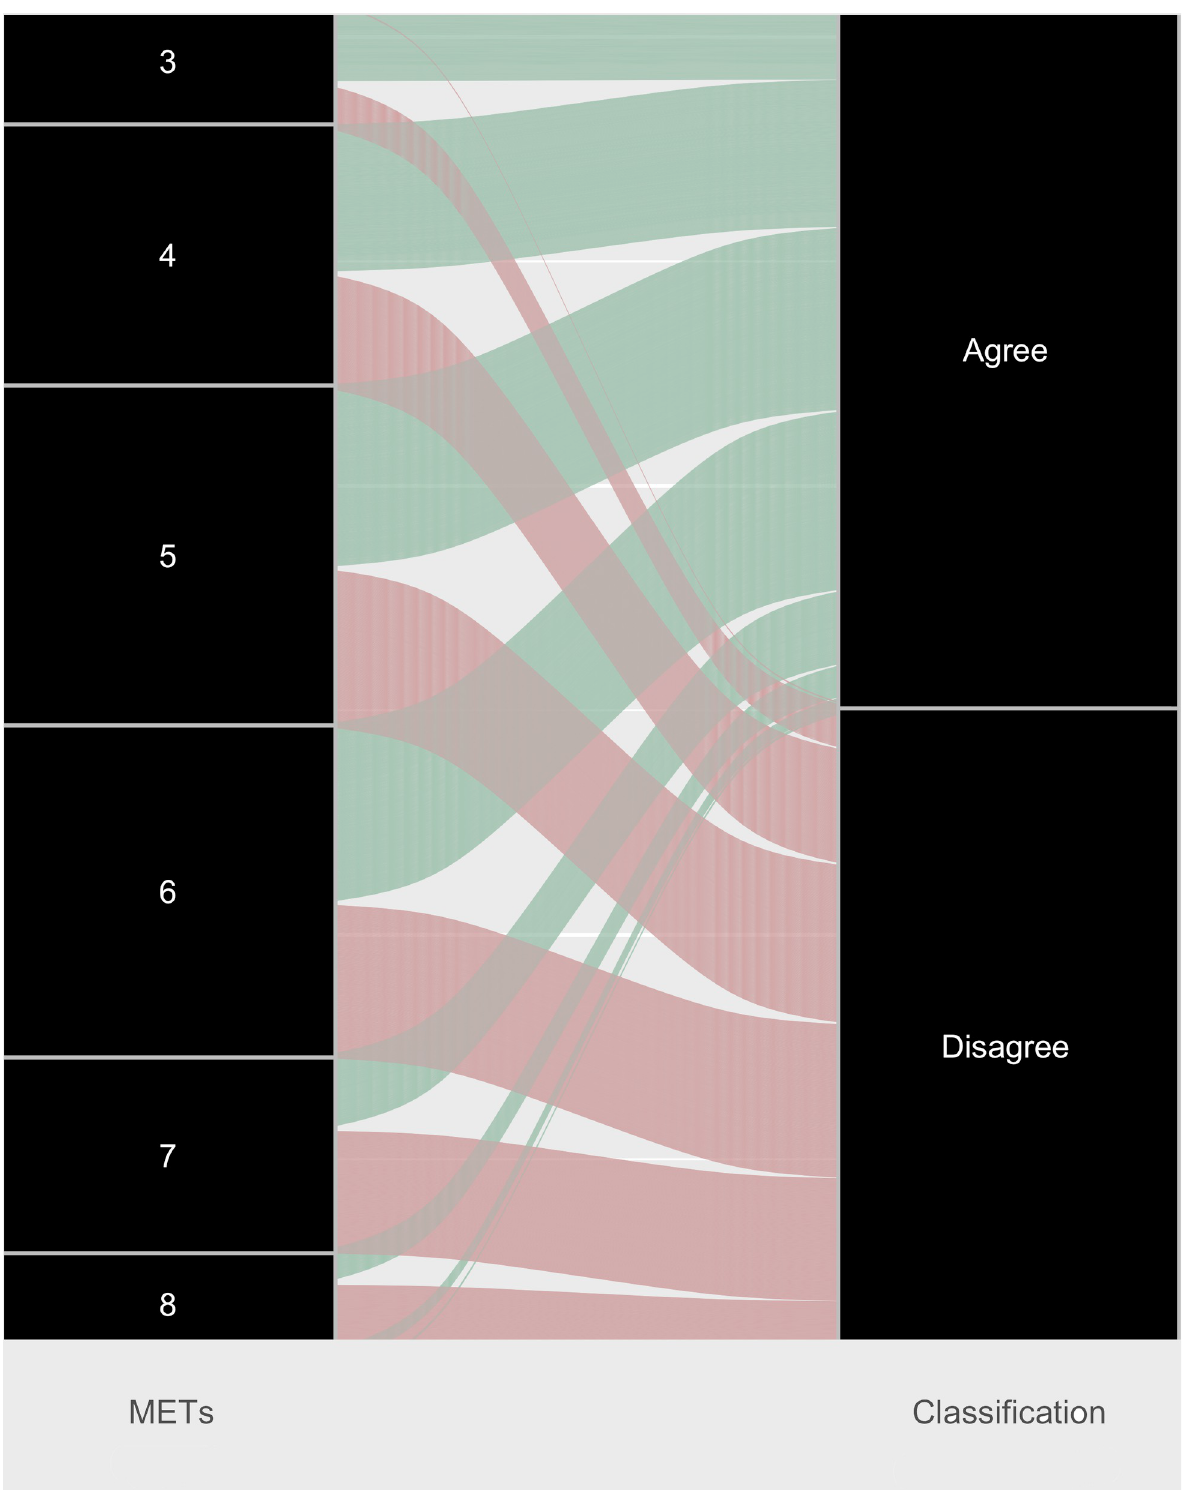
Fig 2. The agreement between absolute and relative measures of moderate-to-vigorous exercise intensity when based on raw data from three studies [35, 36, 51].